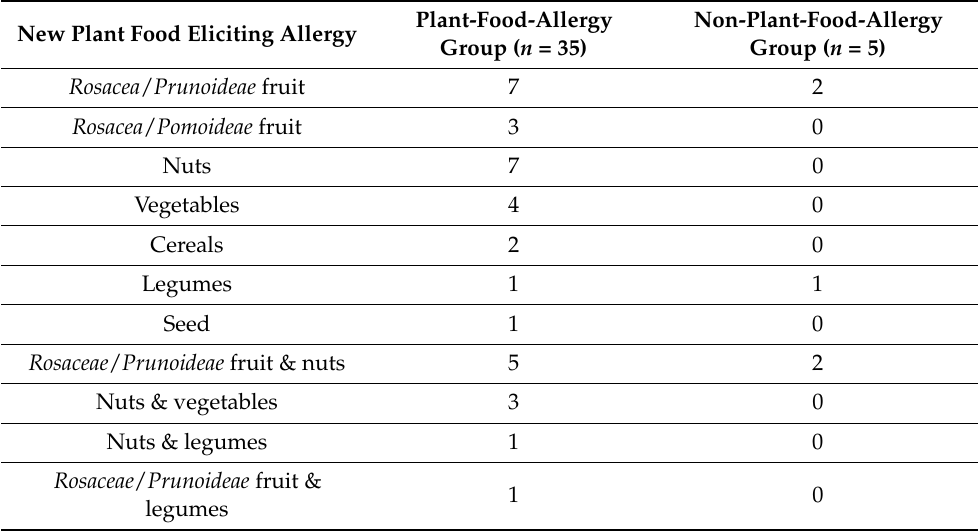
Table 4. Allergy to new plant foods on follow-up study in patients sensitized to nsLTP. New Plant Food Eliciting